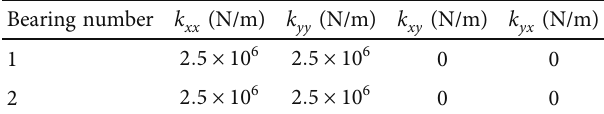
Table 4: Sti ff ness of squirrel cages.